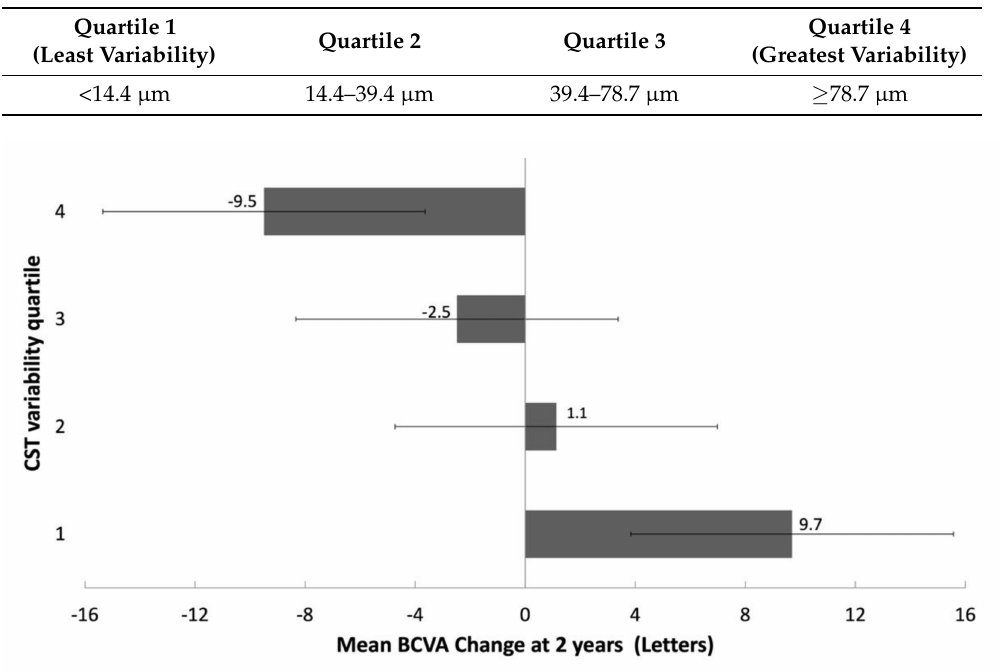
Table 1. OCT CST variability values of the 4 quartile groups during the study period.